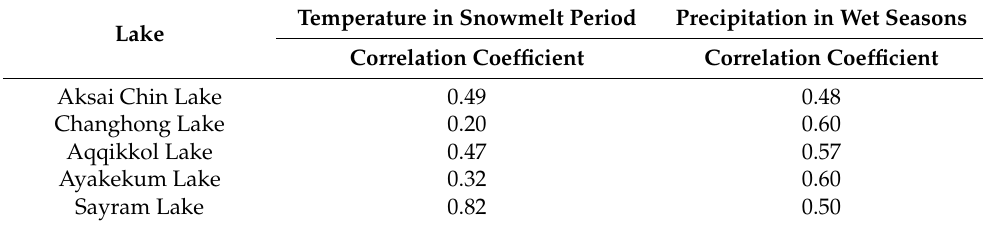
Table 2. The relationship between water levels and climate variables of alpine lakes between 2003 and 2009. Temperature in Snowmelt Period Precipitation in Wet Seasons Lake Correlation Coefficient Correlation Coefficient Aksai Chin Lake 0.49 0.48 Changhong Lake 0.20 0.60 Aqqikkol Lake 0.47 0.57 Ayakekum Lake 0.32 0.60 Sayram Lake 0.82